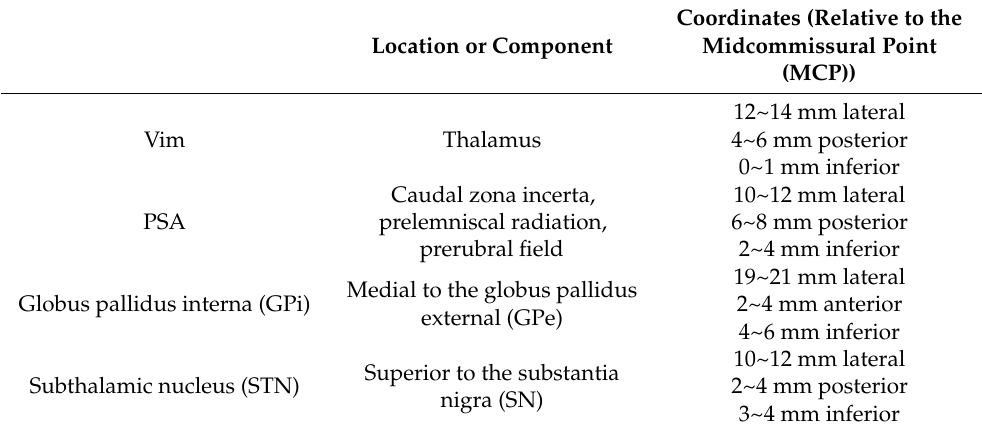
Table 1. DBS targets for